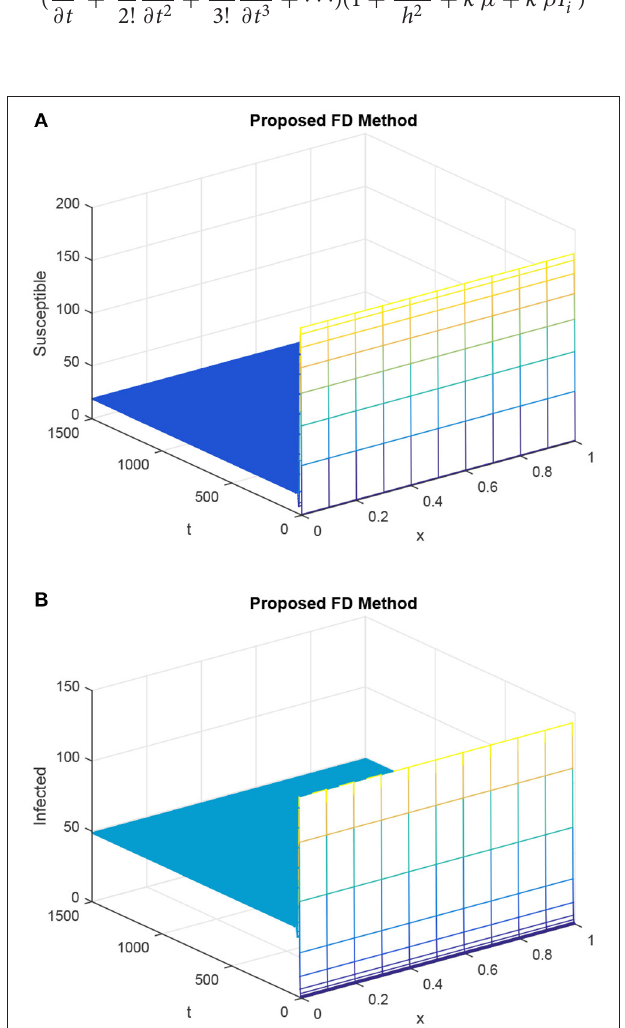
FIGURE 4 | Sketch of susceptible population and infected population, giving the selection of values as h = 0.1 and choosing R 1 = R 2 = 0.15, τ = 1.5 (with proposed scheme). (A) Mesh graph of S . (B) Mesh graph of I